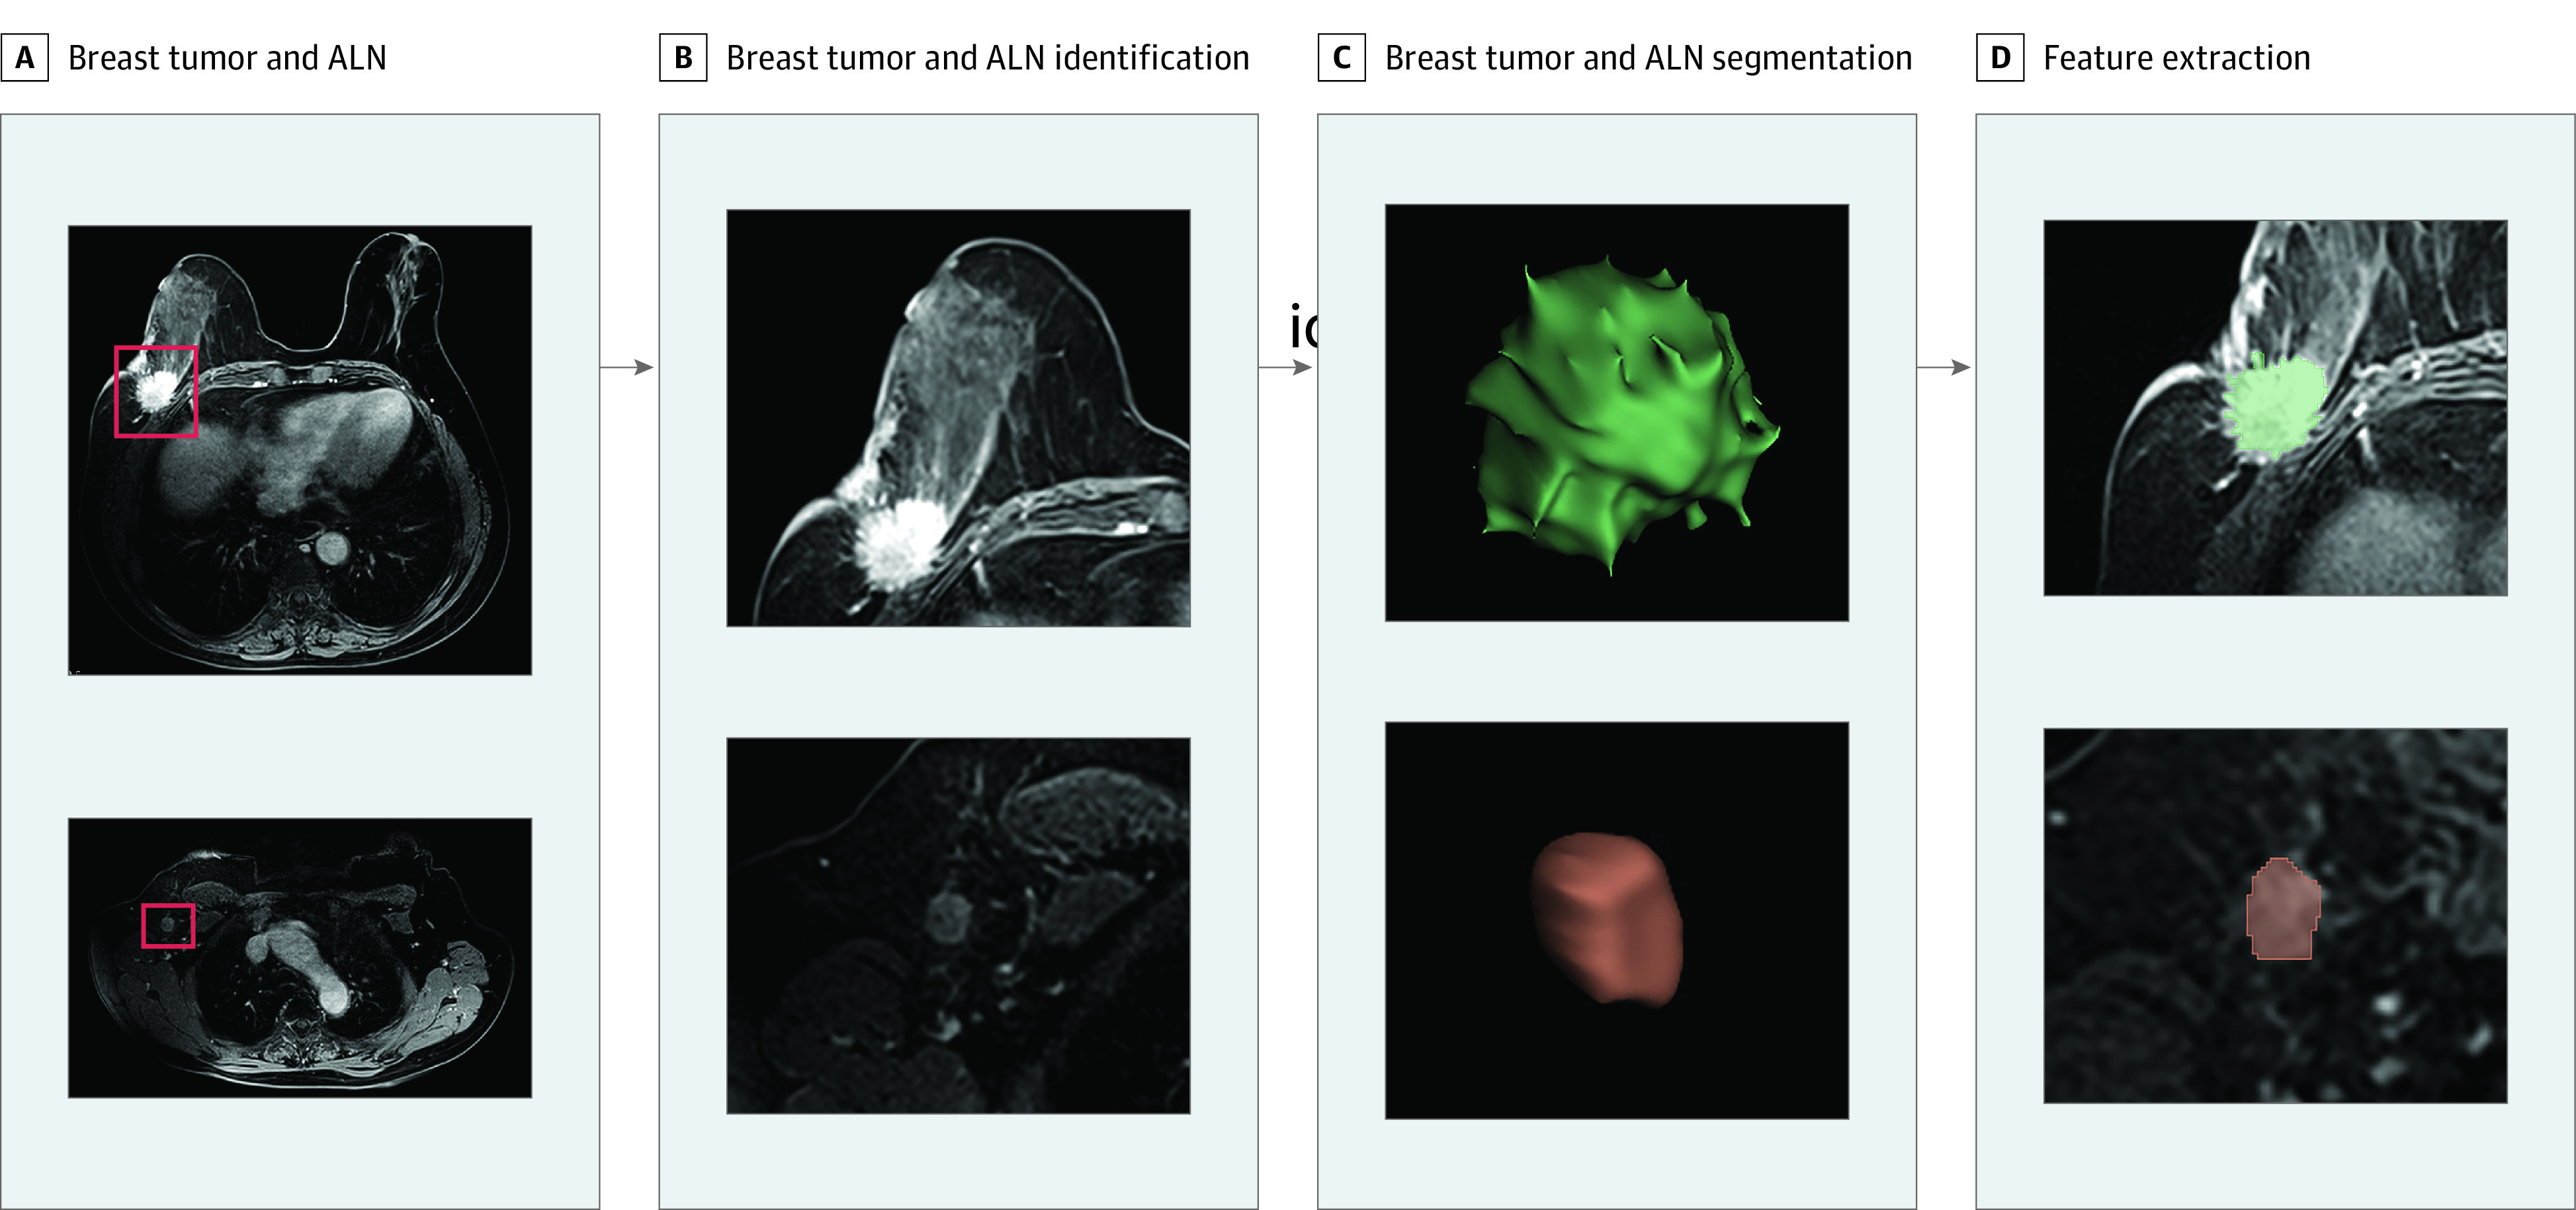
Workflow of Radiomic Feature ExtractionALN indicates axillary lymph node.